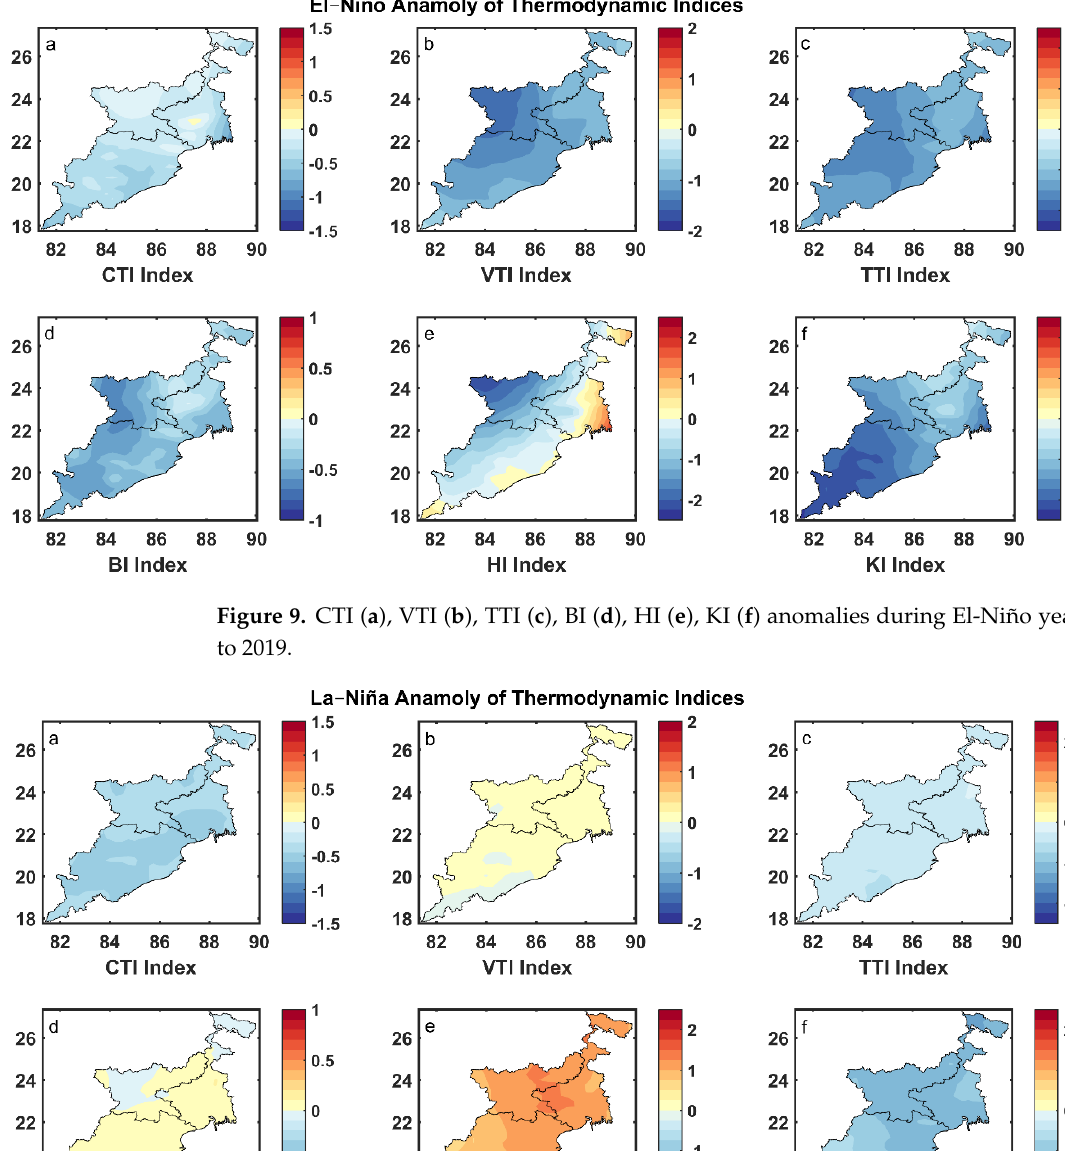
Figure 8. CTI ( a ), VTI ( b ), TTI ( c ), BI ( d ), HI ( e ), KI ( f ) variations during neutral El-Niño and La-Niña years from 1987 to 2019.